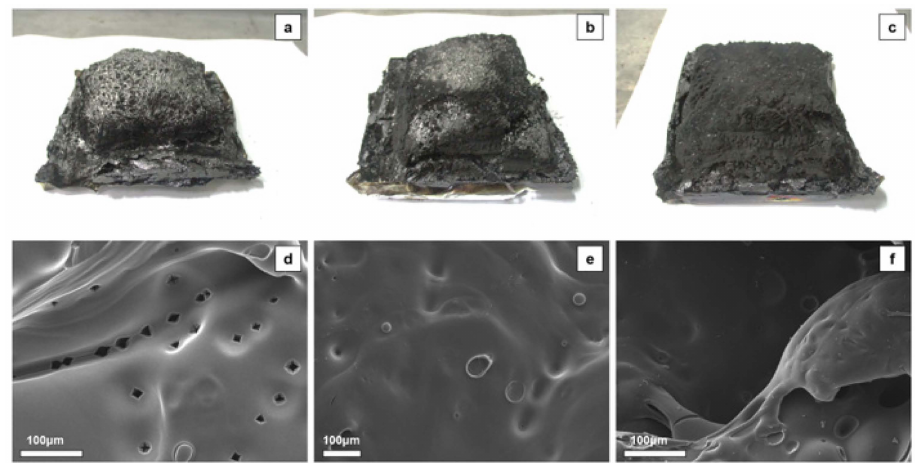
Figure 7. Digital photos of residual char for ( a ) EP0, ( b ) EP5, ( c ) EP10 and SEM images of residual char for ( d ) EP0, ( e ) EP5, and ( f ) EP10 after cone calorimeter test.